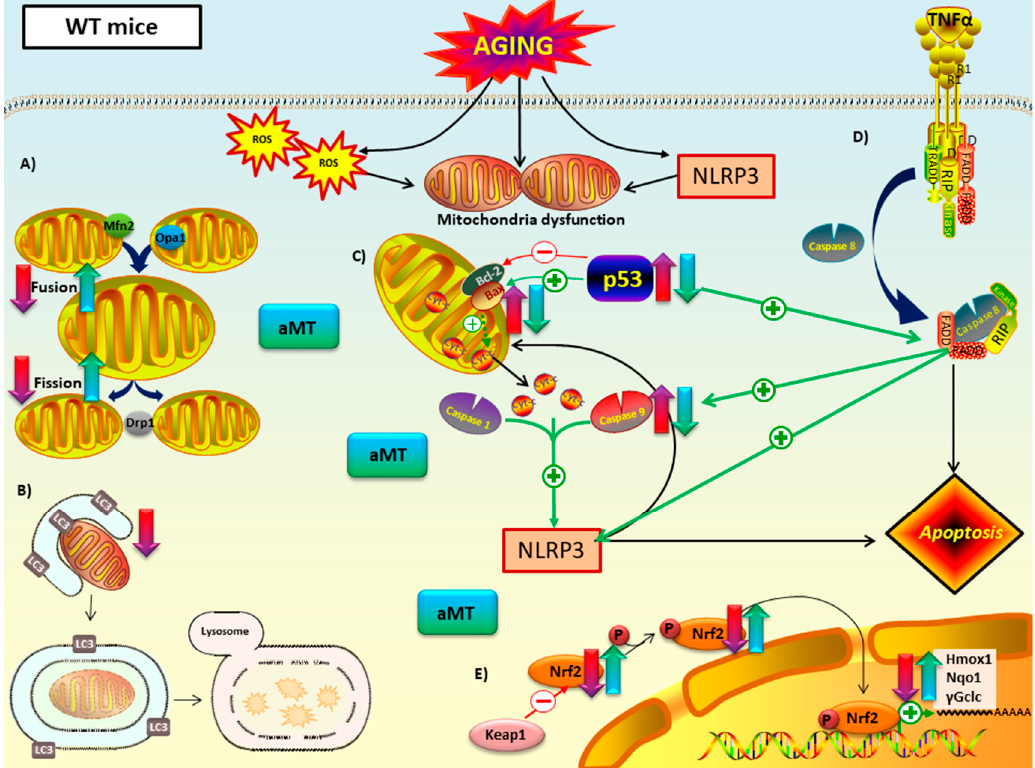
Figure 9. Proposed mechanism of melatonin in mitochondria of WT mice during cardiac aging. ( A ) Mitochondrial dynamics: aging led to a decline in fusion (Mfn2 and Opa1) and fission proteins (Opa1). Melatonin treatment counteracted this decrease. ( B ) Autophagy (mitophagy): autophagic capacity dropped in aged myocardium. Melatonin therapy had minimal impact on this pathway. ( C ) Intrinsic and ( D ) extrinsic apoptosis: WT mice have intrinsic and extrinsic pathways mediated by p53 and caspase 9. Those apoptotic markers, as well as Bax/Bcl2 ratio, increased with aging and are related with NLRP3 activation. This inflammasome seemed to have a regulatory effect on the intrinsic apoptotic pathway, which depends on mitochondria cytochrome c release. Melatonin supplementation had an anti-apoptotic effect in both intrinsic and extrinsic apoptosis. ( E ) Nrf2-dependent antioxidant response: Nrf2 and pNrf2 (Ser40) were reduced with aging. This loss was linked to the decrease of the cytoprotective enzyme transcriptionally regulated by Nrf2: Hmox1, Nqo1 and γ Gclc. Melatonin recovered this antioxidant pathway. No changes in Keap1 were reported. Red-purple arrow: impact of aging. Green-blue arrow: effect of melatonin treatment.